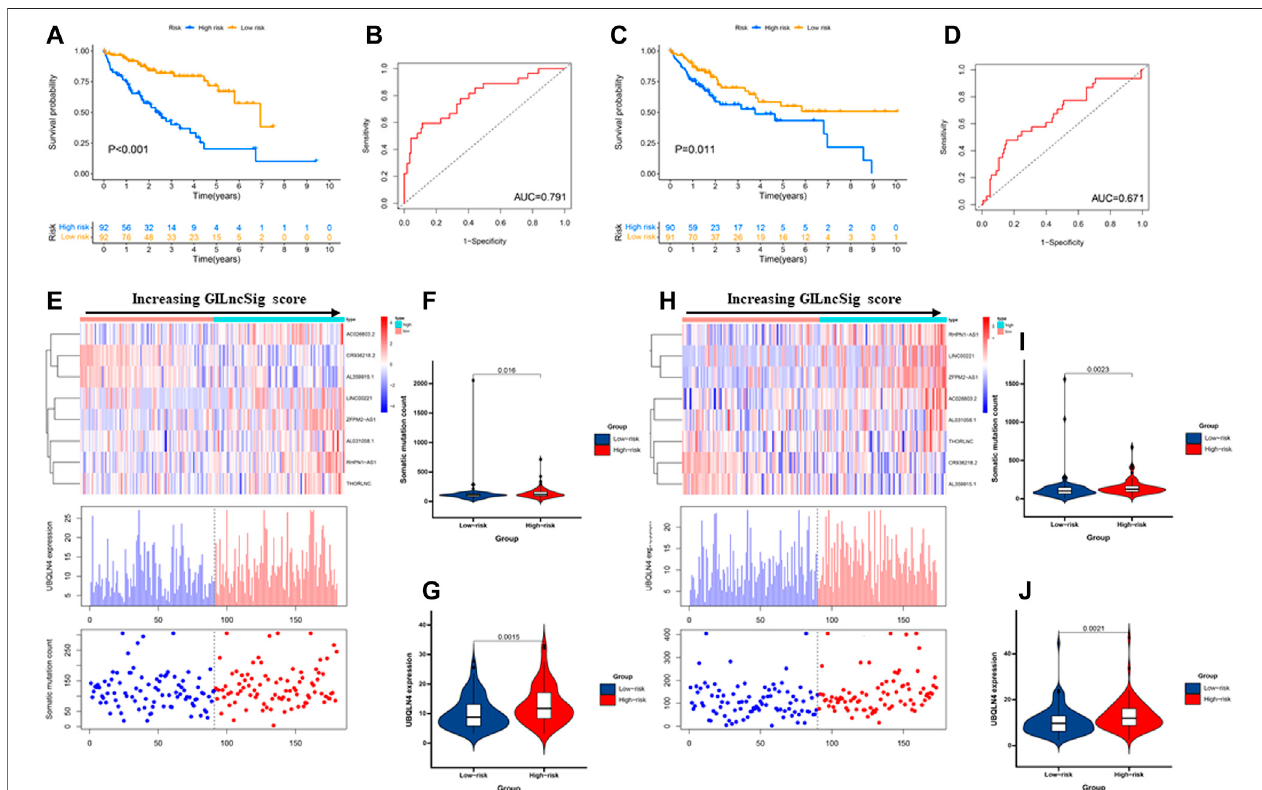
FIGURE4| Performance evaluation of the GILncSig in the training set and testing set. Kaplan – Meier estimates of overall survivalof patients with low or high risk predicted by the GILncSig in the training set (A) and testing set (C) . Statistical analysis was performed using the log-rank test and univariate Cox analysis. Time-dependent ROC curves analysis of the GILncSig at 1 year in the training set (B) and testing set (D) . LncRNA expression patterns and the distribution of somatic mutation count distribution and UBQLN4 expression for patients in high- and low-risk groups in the training set (E) and testing set (H) . The distribution of somatic mutation in patients of high- and low-risk groups in the training set (F) and testing set (I) . The distribution of UBQLN4 expression in patients of high- and low-risk groups in the training set (G) and testing set (J) . Horizontal lines: median values. Statistical analysis was performed using the Mann – Whitney U